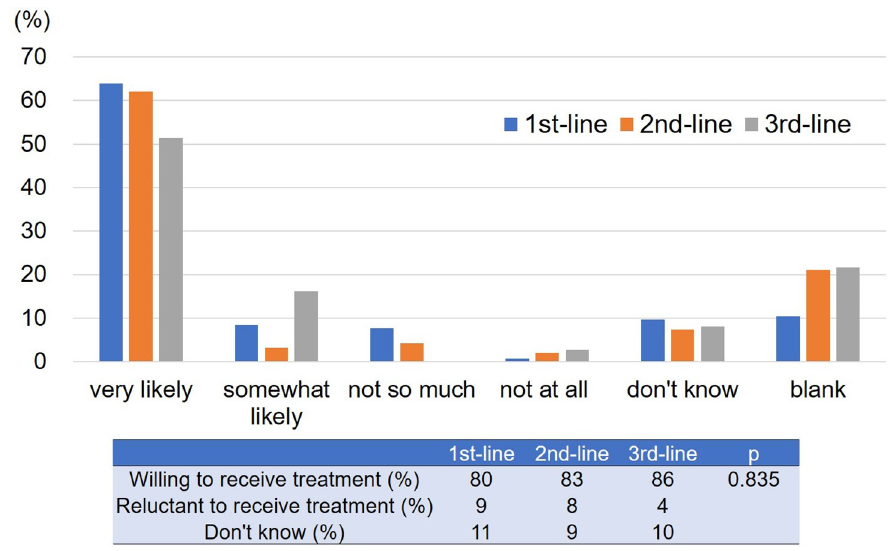
Fig 2. The response and the change in the response rate to Question 2. The patients who were indicated that they were willing to receive treatment remained > 80% in the 1 st to 3 rd treatment line.